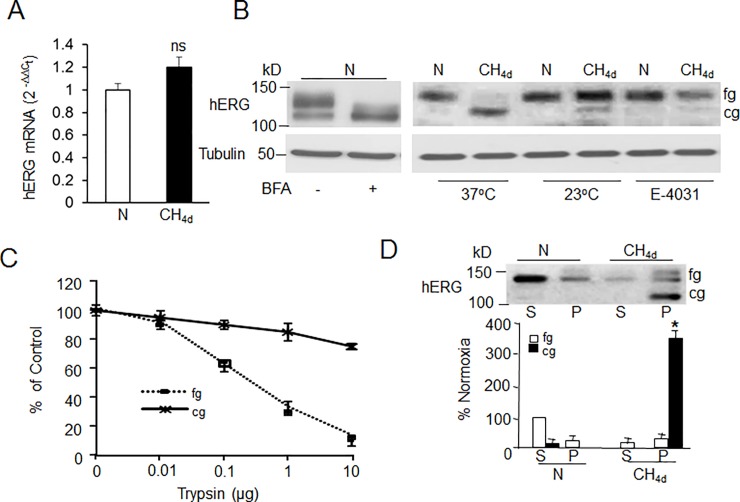
Continuous hypoxia (CH) impairs hERG trafficking.A) Quantitative real-time PCR analysis of hERG mRNA levels in SH-SY5Y cells exposed to normoxia (N) or CH4d. The data are mean ± SEM; n = 3 individual experiments. B) Representative immunoblot analysis of hERG protein in cells exposed to normoxia (N) with and without 5μM brefaldin treatment. Effect of temperature and antiarrhythmic drug (E-4031; 5μM) on hERG expression in normoxia and CH exposed cells. C) Trypsin sensitivity of 150kDa and 125kDa forms of hERG. Total cell membrane lysates from normoxia and CH exposed cells were treated with different concentrations of trypsin followed by immunoblotting with hERG antibody. Densitometric analysis (mean ± SEM) of hERG protein normalized to tubulin and expressed as percentage of control (without trypsin treatment). D) Detergent extractability of hERG from cell lysates exposed to normoxia and CH. Equal amounts of detergent soluble (S) and insoluble (P) proteins from normoxia and CH exposed cells were analyzed by immunblotting. Data are mean ± SEM. from 3 individual experiments. * denotes p <0.01.